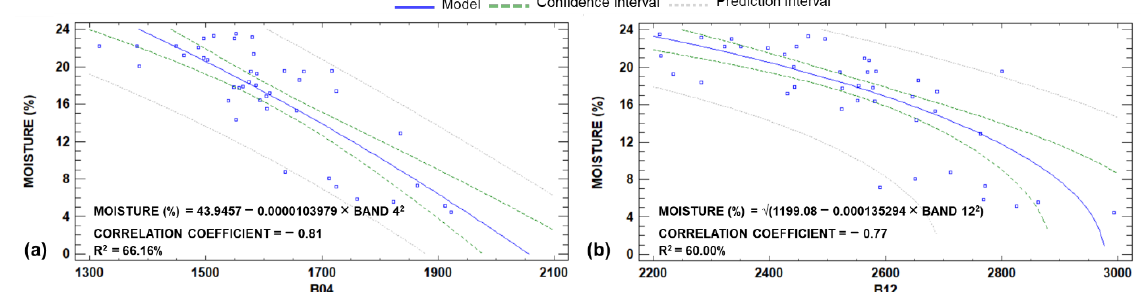
Figure 7. Simple Regression Models for clay soil with ( a ) band 4 and ( b ) band 12 for bands with 20 m of resolution.